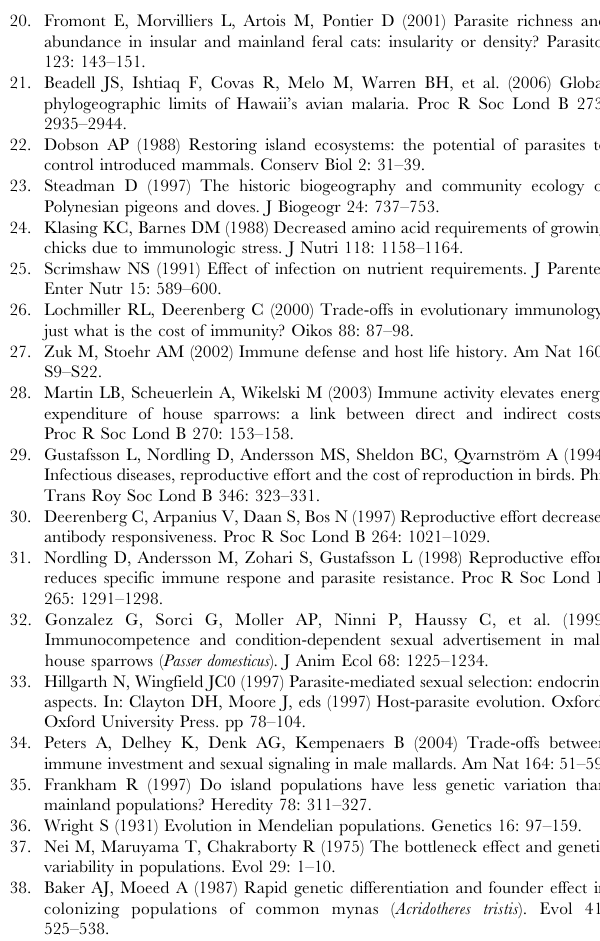
Table S1 PCR conditions for microsatellite